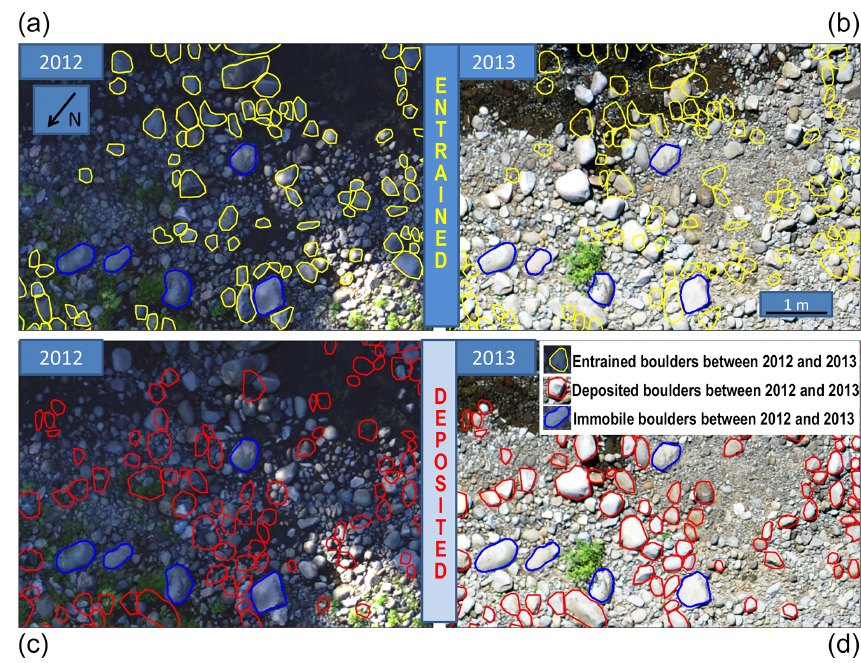
Figure 3. Surface of the bar in March 2012 (a, c) and June 2013 (b, d) . Boulders entrained by the river between 2012 and 2013 are marked by yellow contours (a, b) . Boulders deposited by the river between 2012 and 2013 are marked by red contours (c, d) . Boulders that stay in place between 2012 and 2013 are marked by blue